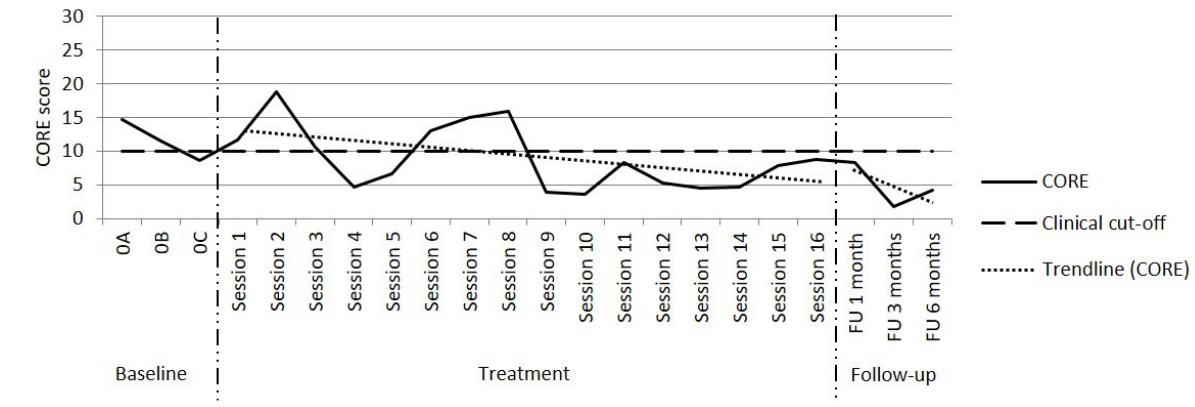
Figure 2: Beatrice’s weekly anxiety (GAD -7) score